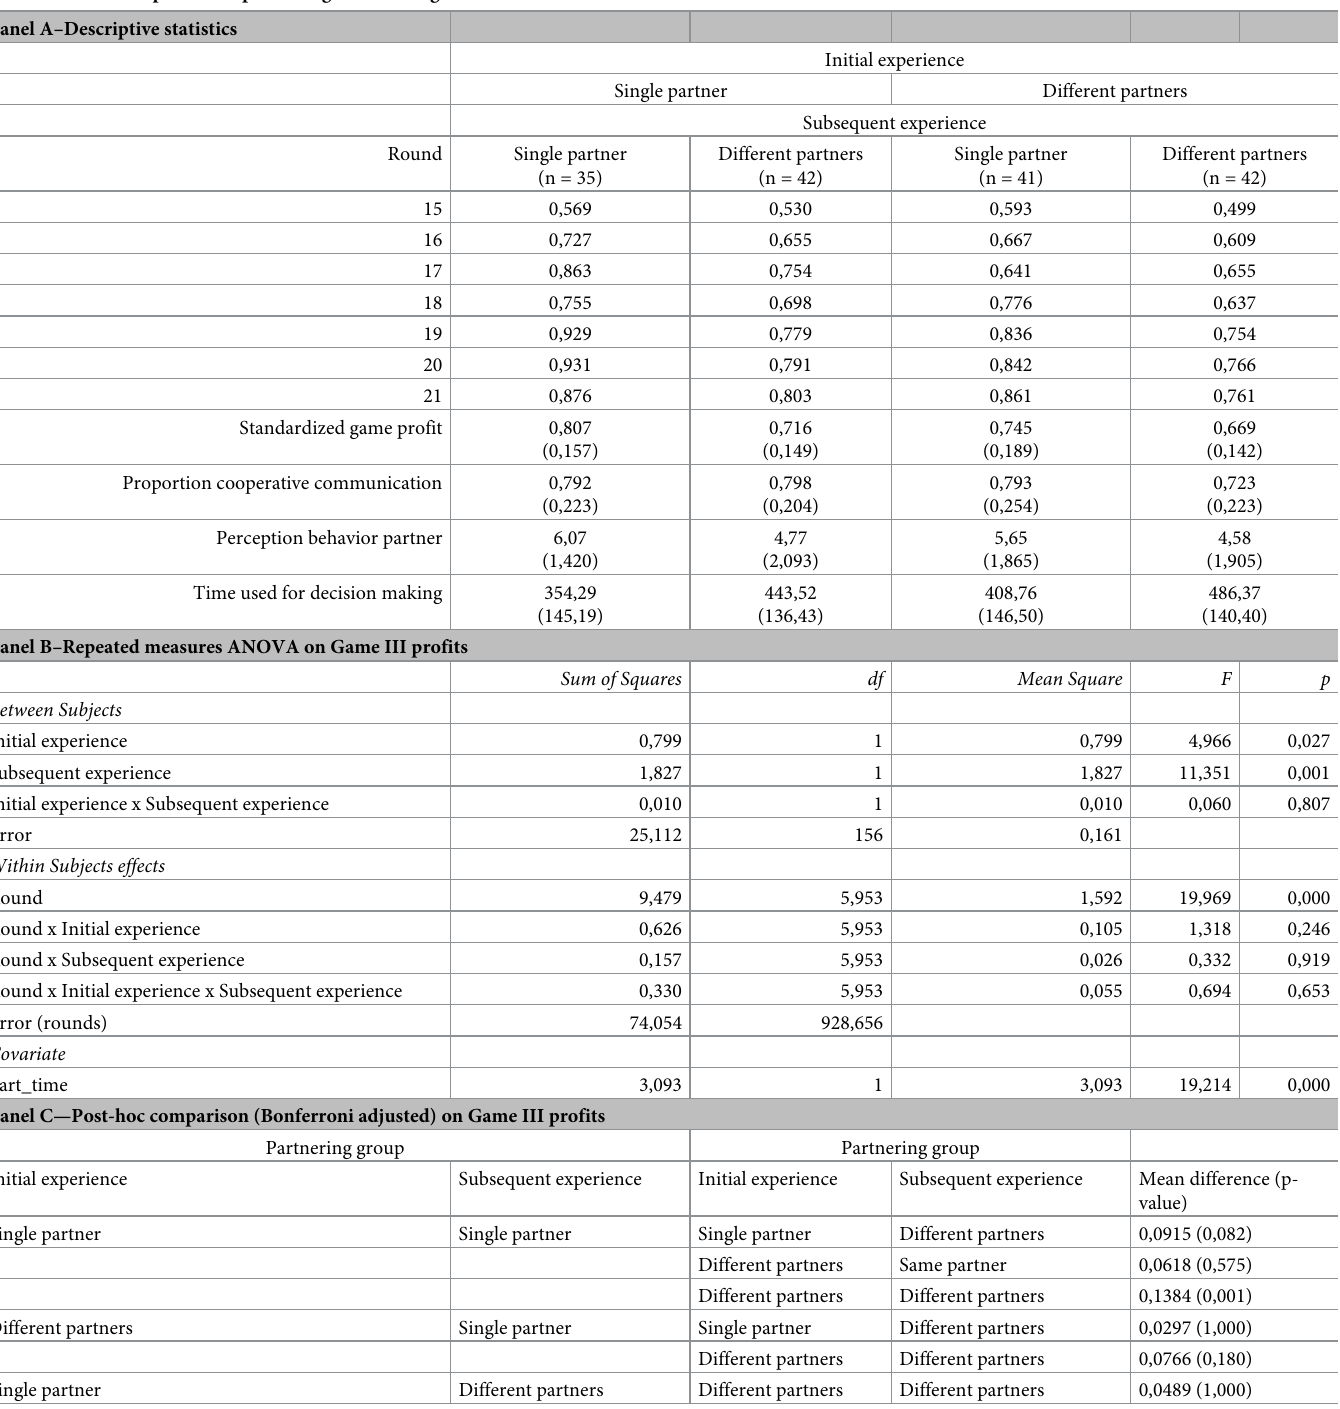
Table 6. Results on profits for partnering treatments game